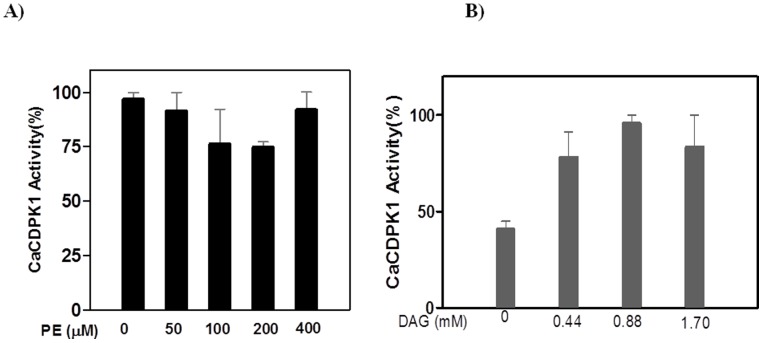

CaCDPK1 activity in presence of added PE and diacylglycerol.A) Kinase activity was measured in presence of PE. Reaction mixtures contained 50 ng of CaCDPK1 in 50 mM Tris-HCl buffer (pH 7.2), 1.2 mM CaCl2, 1 mM EGTA, 10 mM MgCl2, 1 mg/ml histone and indicated amount of PE. B) CaCDPK1 activity in presence of high concentrations of diacylgylcerol. Kinase activity was measured in presence of diacylglycerol. The reaction mixture contained 50 ng of CaCDPK1 in 50 mM Tris-HCl buffer (pH 7.2), 1.2 mM CaCl2, 1 mM EGTA, 10 mM MgCl2, 1 mg/ml histone and indicated amounts of DAG.